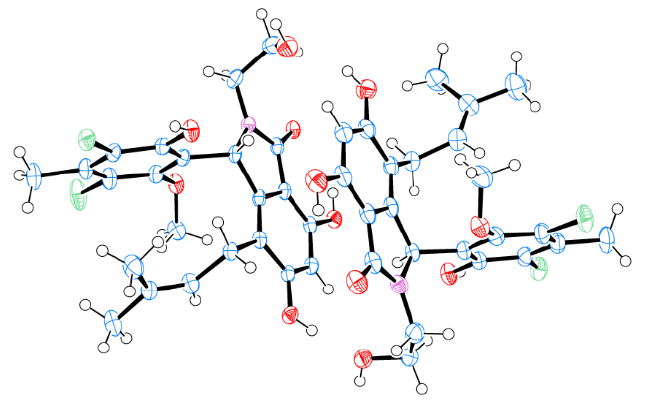
Figure 5. Perspective ORTEP drawing for (±) pestalachloride A1a ( 1a ).